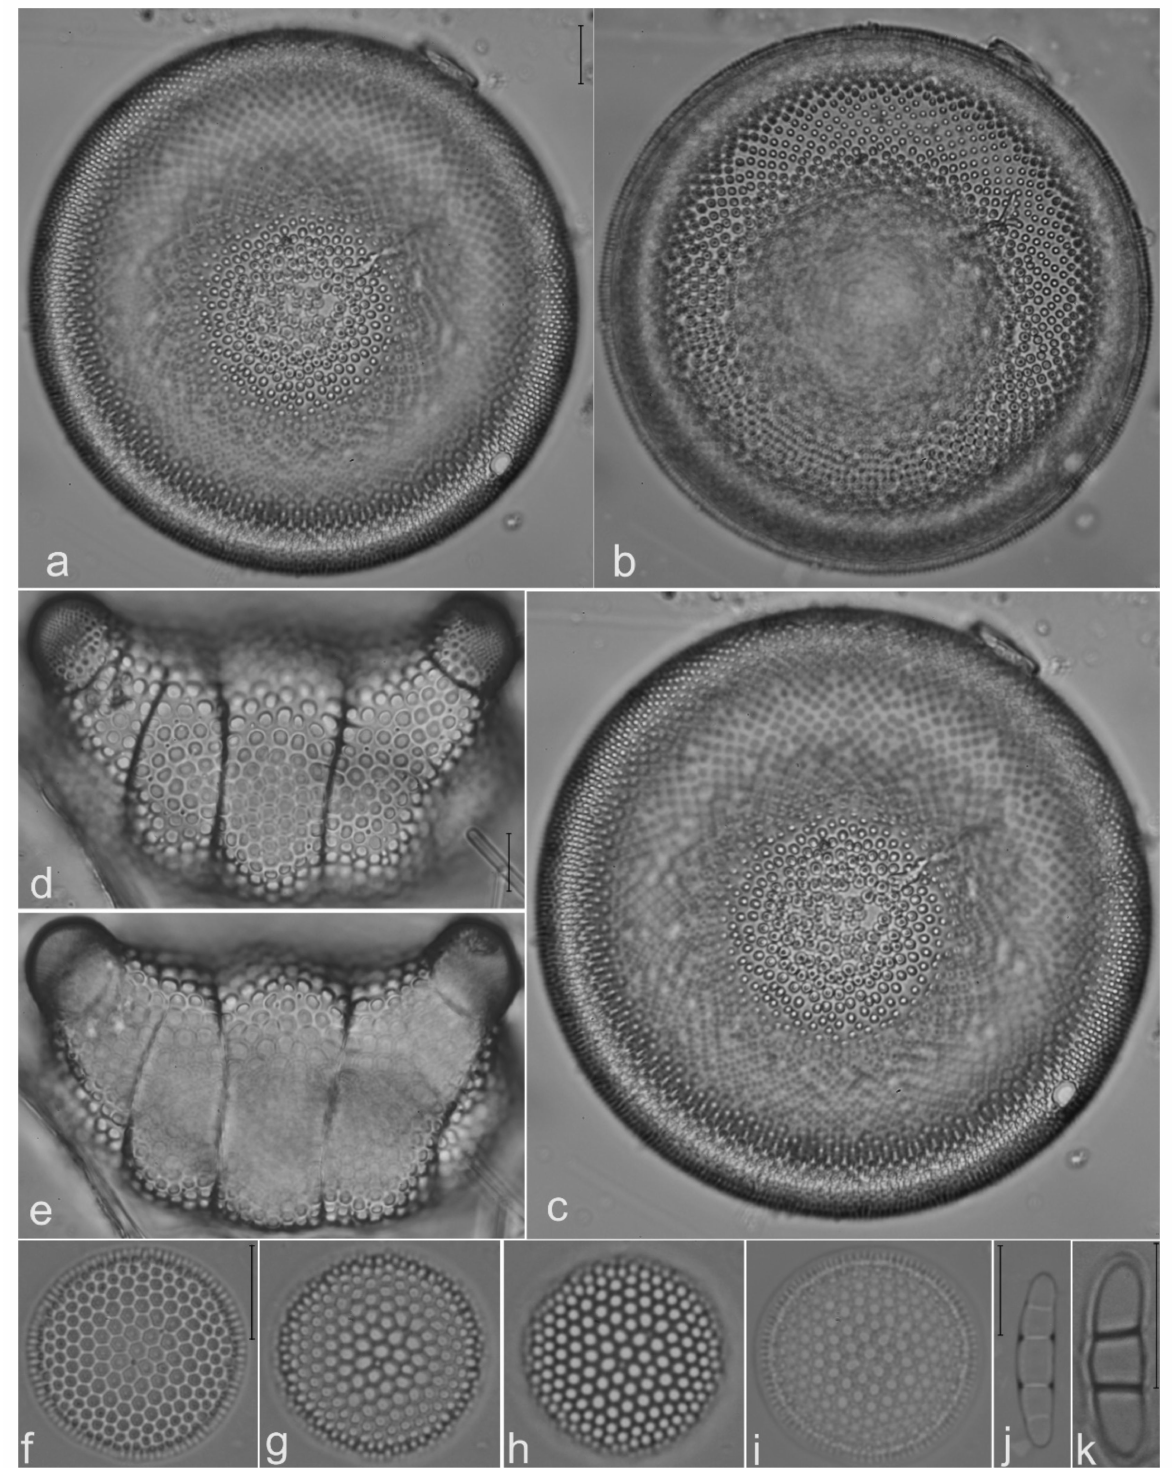
Figure 4. ( a – c ) Actinocyclus gallicus in different focal views; ( d , e ) Biddulphia biddulphiana ; ( f – i ) Shionodiscus oestrupii in different focal views; ( j , k ) Anaulus minutus . Scale bar = 10 µ